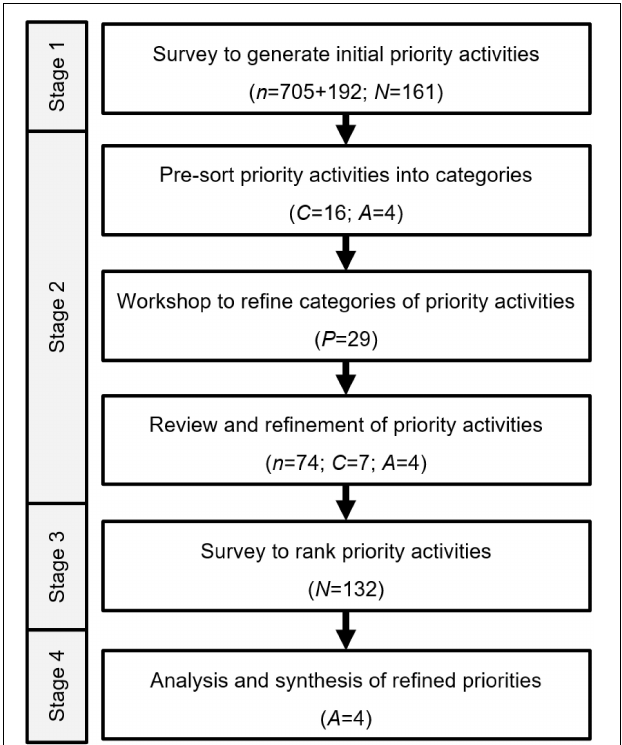
FIGURE 2 | Process diagram summarising the four stages of the methodology undertaken to identify the priorities at each stage of the process; n = number of priorities at relevant stages of the process; N = the number of survey respondents for each of the two online surveys; C = number of categories at relevant stages of the process; A = number of authors involved in the assessment process; and P = number of workshop participants. In Stage 1, n is shown as number of research priorities and number of priorities for infrastructure and equipment,